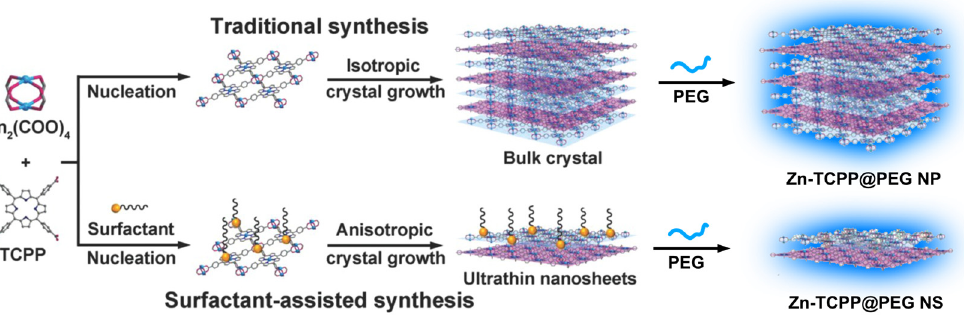
Figure 11. NMOF sheets general preparation method and PEG coating. Reprinted/adapted with permission from Ref. [106] .